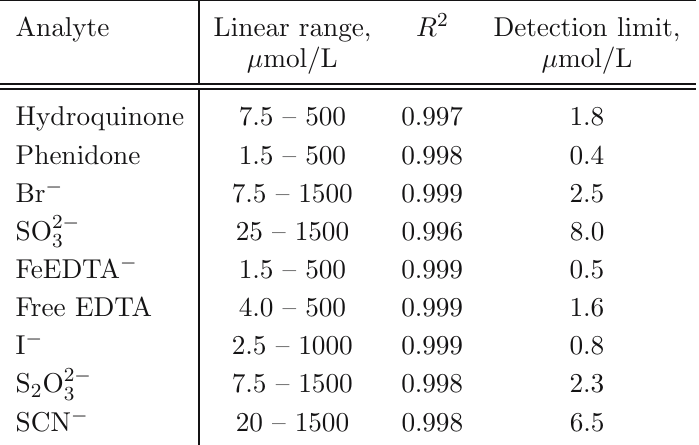
Table 1 Linearity data and detection limit values.